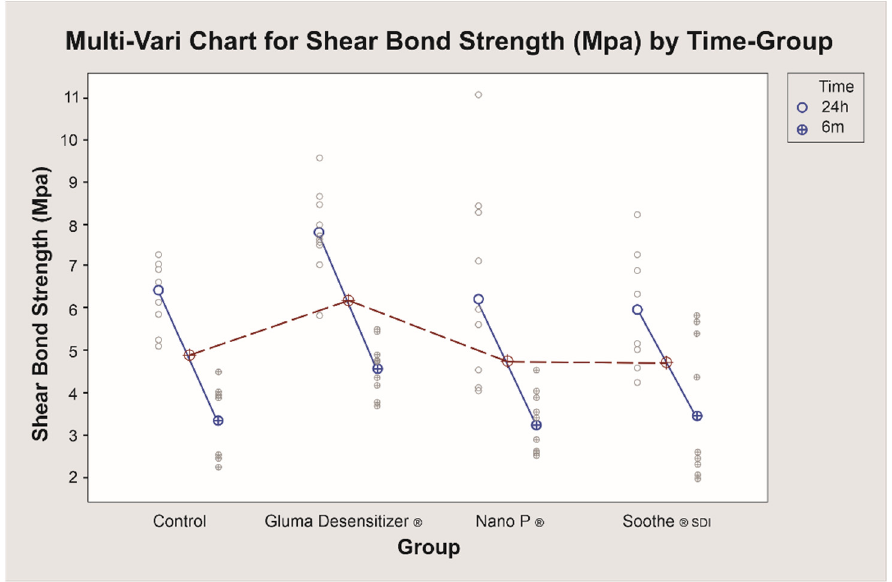
Figure 3. Shear bond strength (MPa) values at 24 h and 6 months. Red circles indicate mean for both aging times.